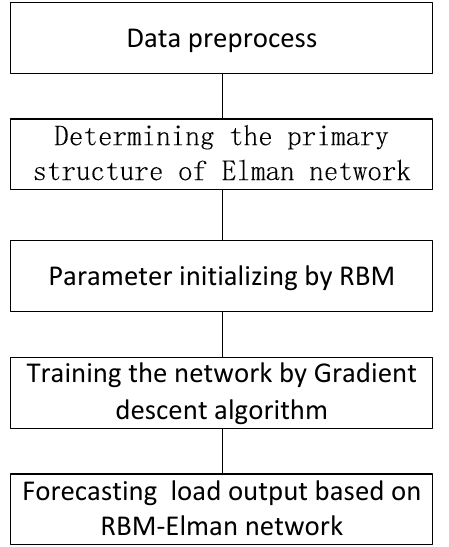
Figure 4. The flowchart of the RBM-Elman model.